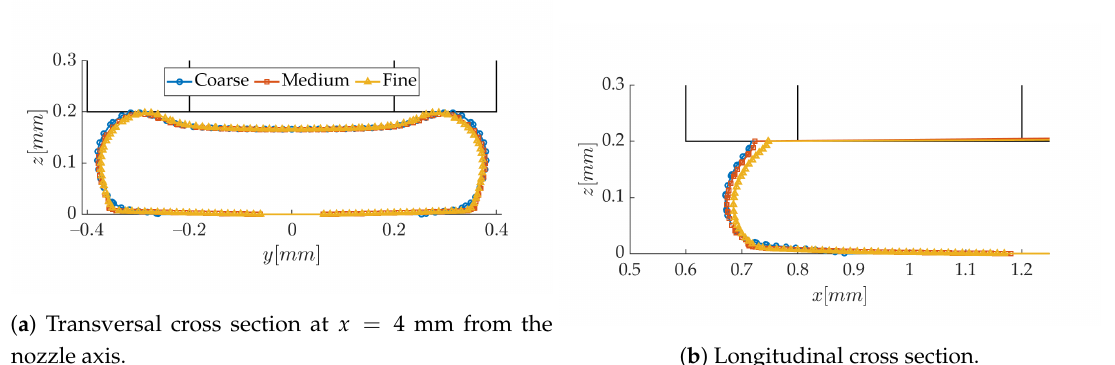
Figure 10. Mesh independency study based on the strand shape ( h / d = 0.5, V / U = 1).